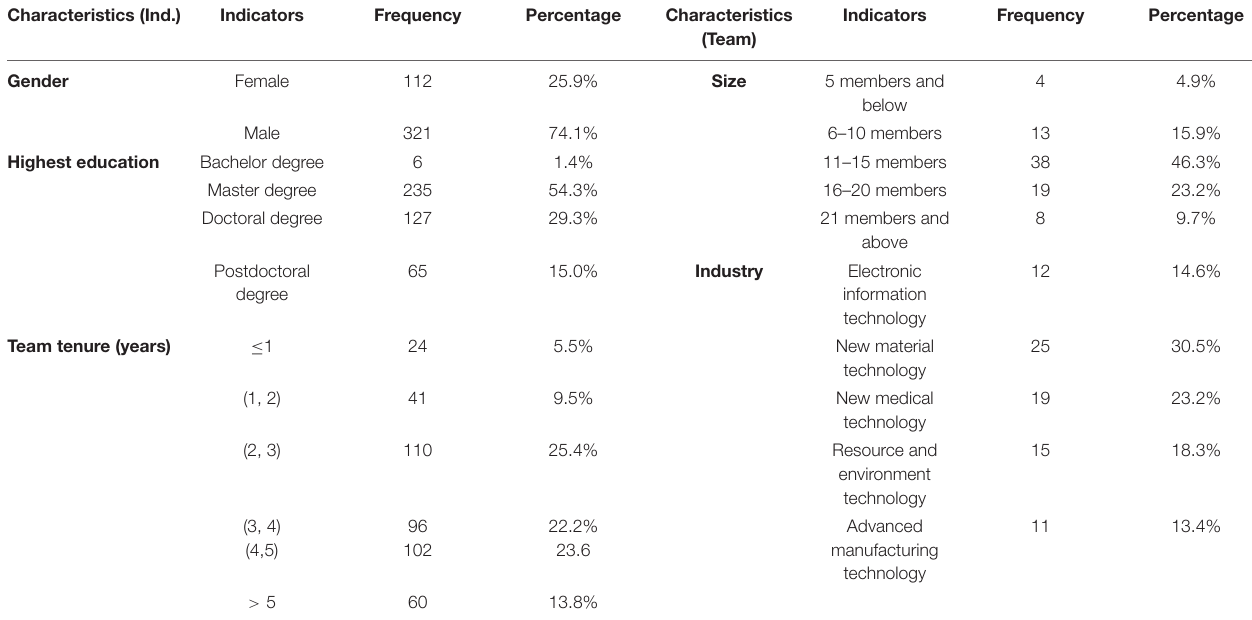
FIGURE 1 | The research conceptual model. TABLE 2 | Sample characteristics (Ind.: 433; Team: 82). Characteristics